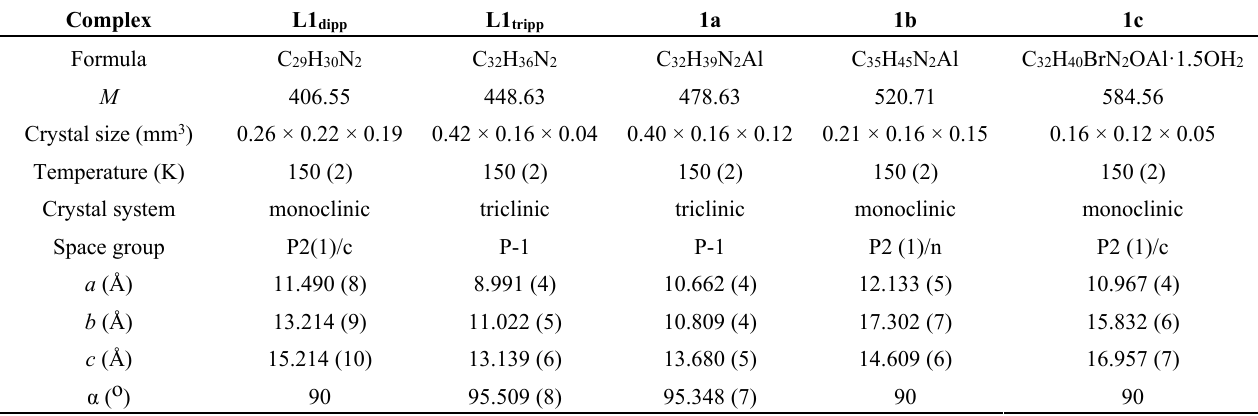
Table 4. Crystallographic and data processing parameters for L1 dipp , L1 tripp , 1a , 1b and 1c